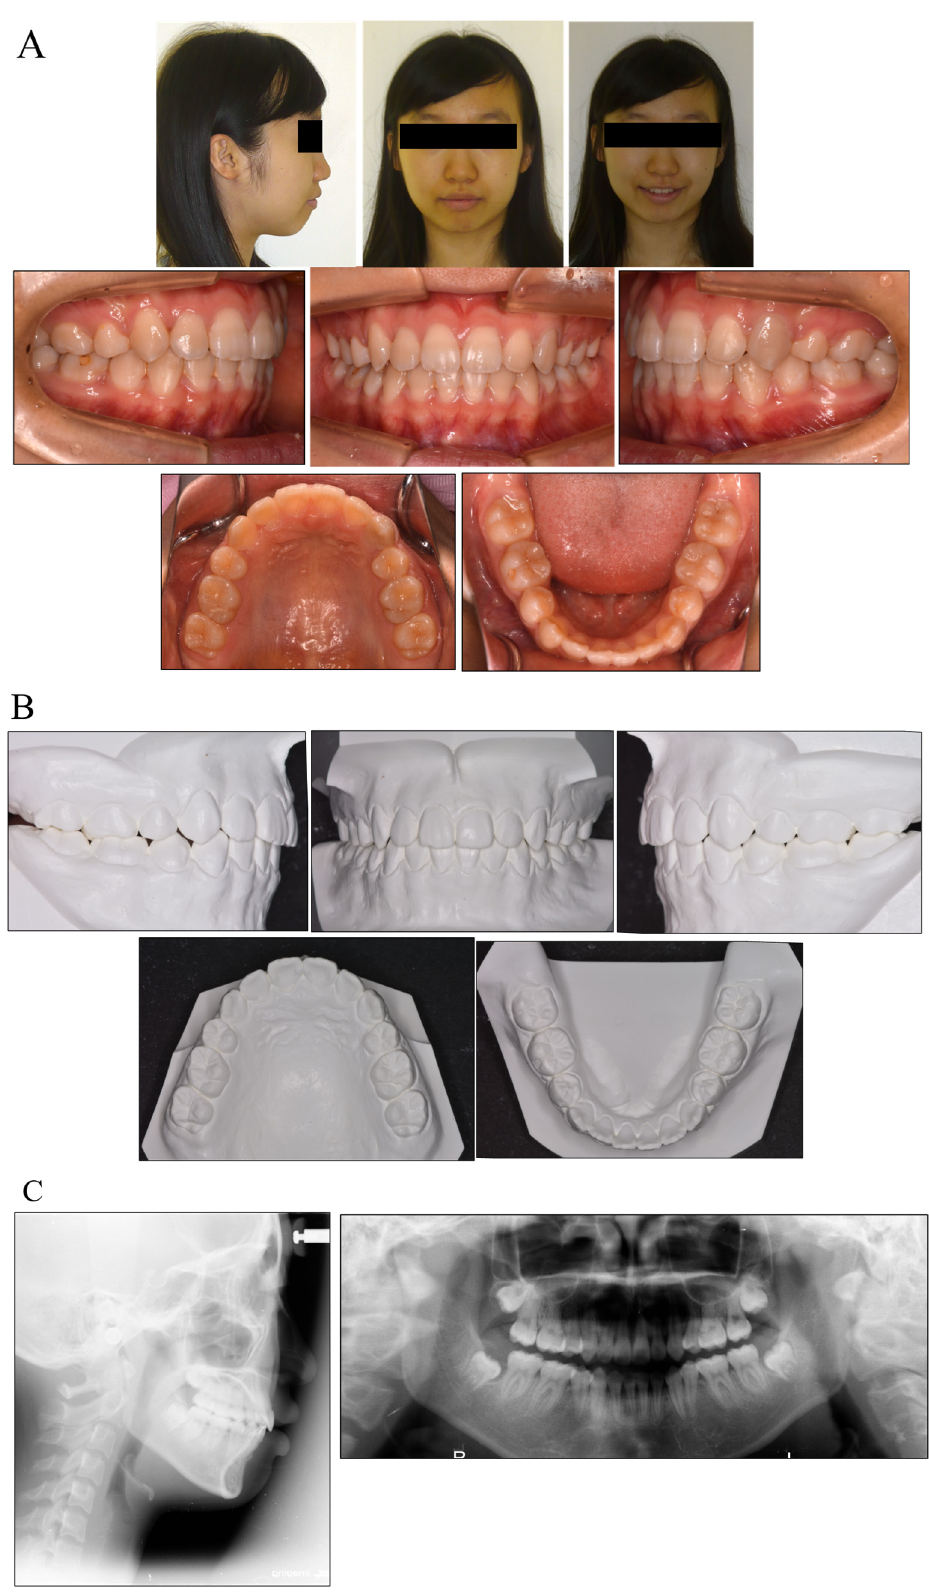
Figure 3. Facial and intraoral photograph ( A ), dental casts ( B ) and radiographs (( C ) lateral cephalo- gram; panoramic radiograph) of post-treatment (patient is 17 years old).